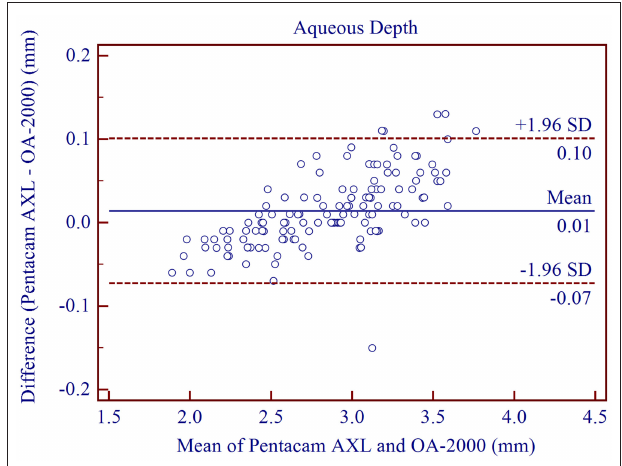
FIGURE 5 | Bland-Altman plots showing the agreement between the new Scheimpflug imager in combination with partial coherence interferometry biometer and the swept-source optical coherence tomography-based biometer for measuring mean keratometry at 3.0mm. Solid lines represent the bias between the two devices and dotted lines represent the 95% confidence interval for the difference.